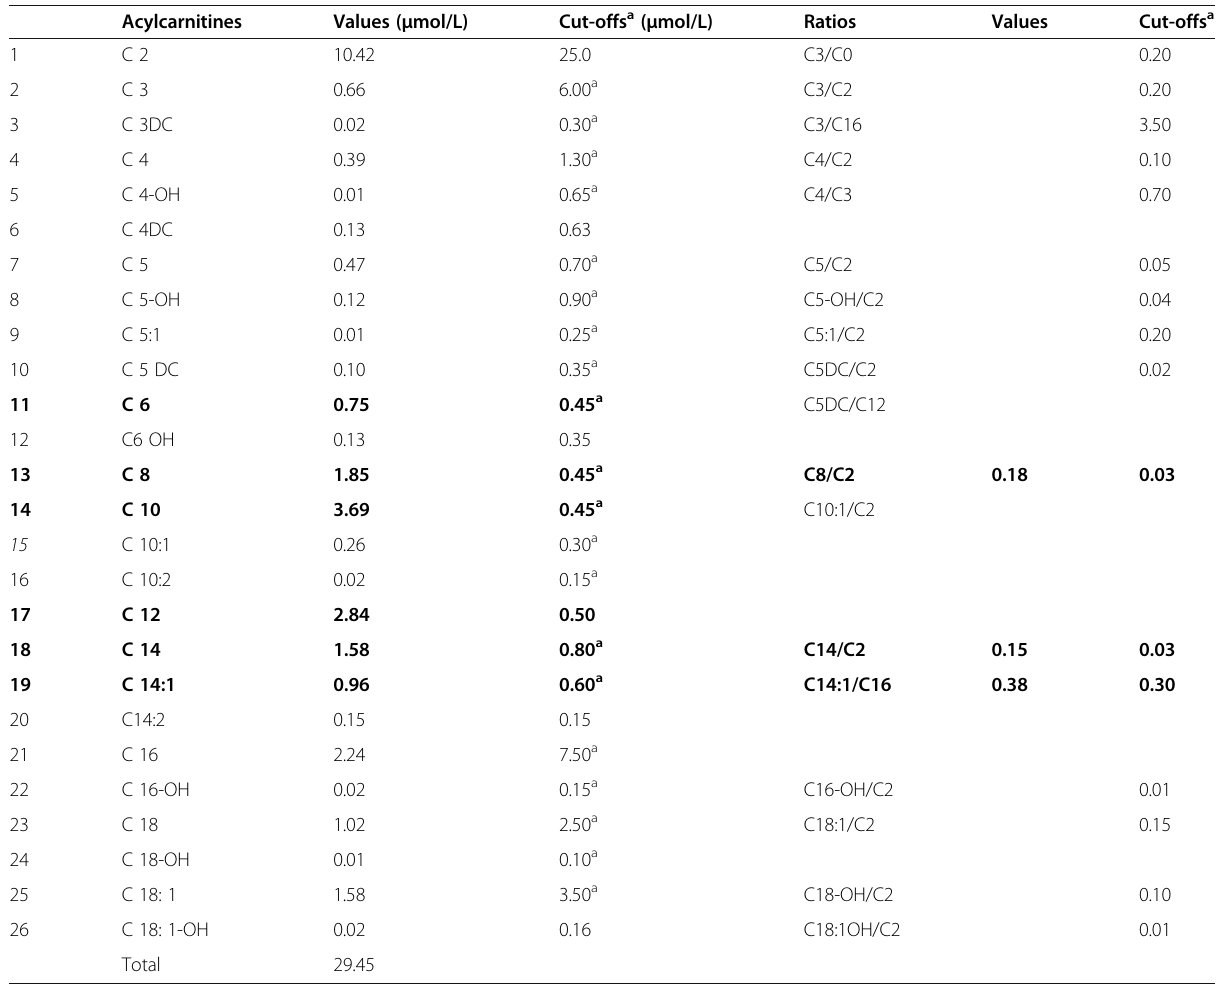
Table 1 Serum acylcarnitine profile at diagnosis (TMS)